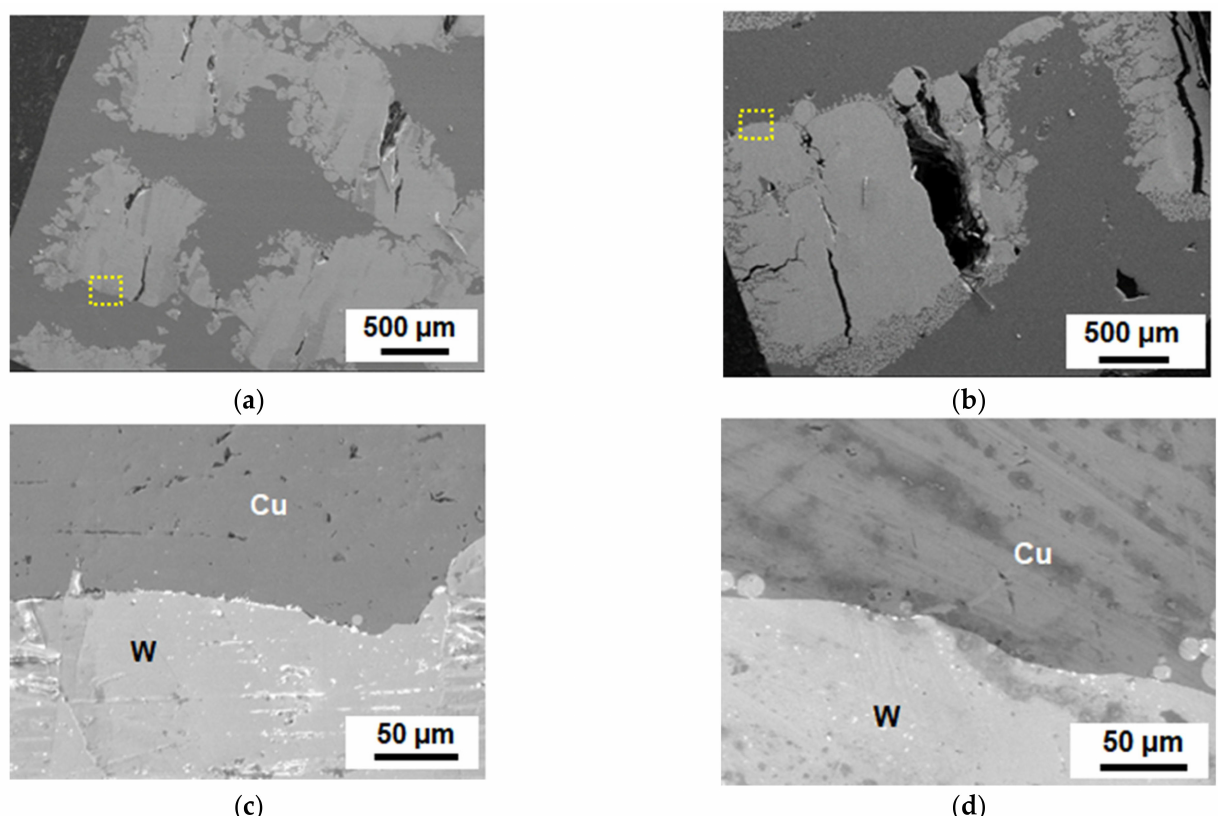
Figure 11. The SEM microscopy of the Cu-W composites with the rhombic dodecahedron ( a ) and cubic ( b ) W-skeleton after 20% compressive strain. The white phase shows the W-skeletons and the black phase is the Cu. ( c , d ) are enlarged images at the Cu and W interface circled in ( a , b ). These images show that cracks mainly formed in W-skeletons and there were no significant cracks and delamination at the Cu and W